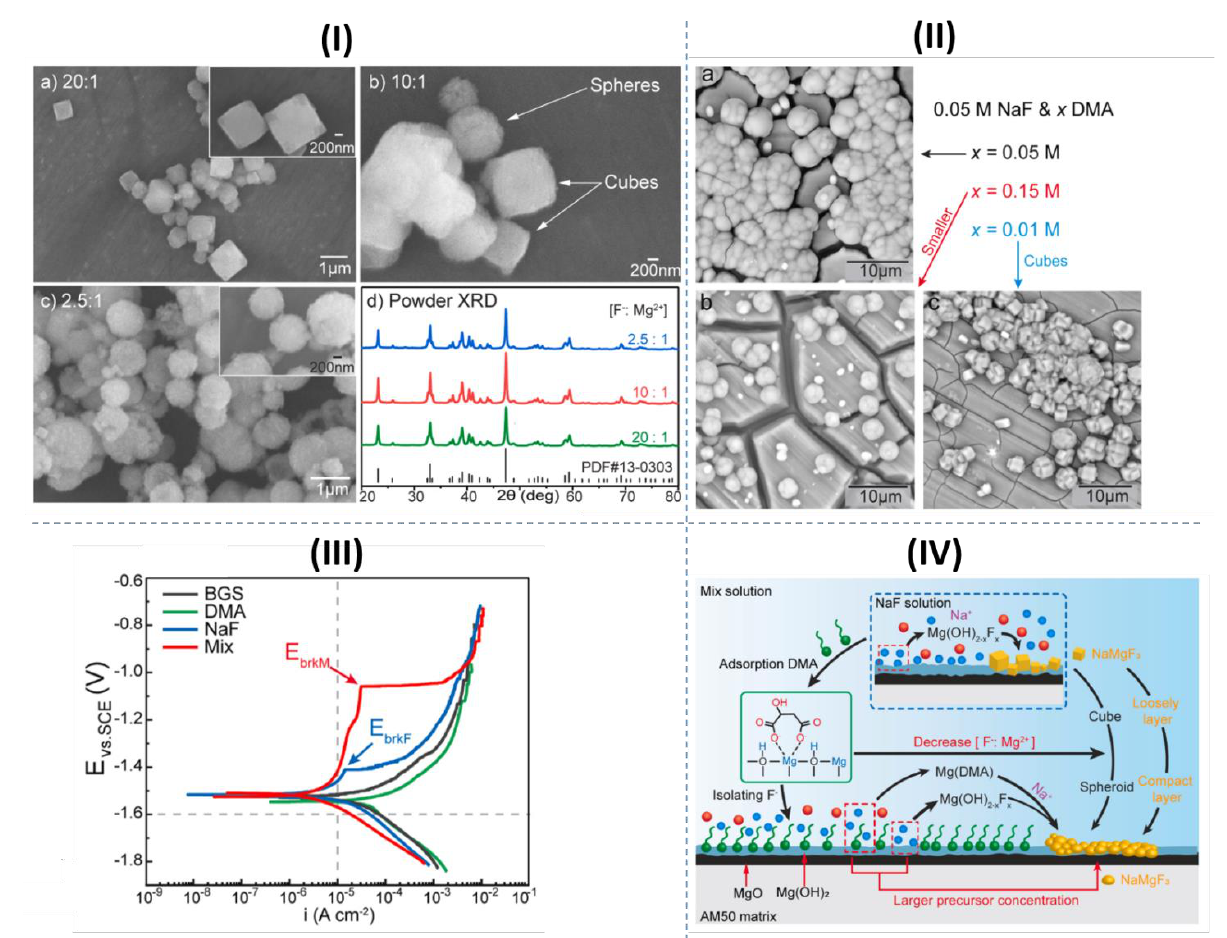
Figure 16. ( I ) The morphology of NaMgF 3 particles synthesized at varied reactants (NaF: MgCl 2 ) molar ratios of ( a ) 20:1, ( b ) 10:1, ( c ) 2.5:1, and ( d ) the XRD patterns of the synthesized particles. ( II ) Morphology of NaMgF 3 particles obtained from Mix solutions containing 0.05 M NaF and different molar concentrations of DMA ( a ) 0.05 M, ( b ) 0.15 M, and ( c ) 0.01 M. ( III ) Potentiodynamic polariza- out 0.05 M DMA, 0.05 M NaF, and Mix after 24 h of stabilization. ( IV ) Schematic illustration of the